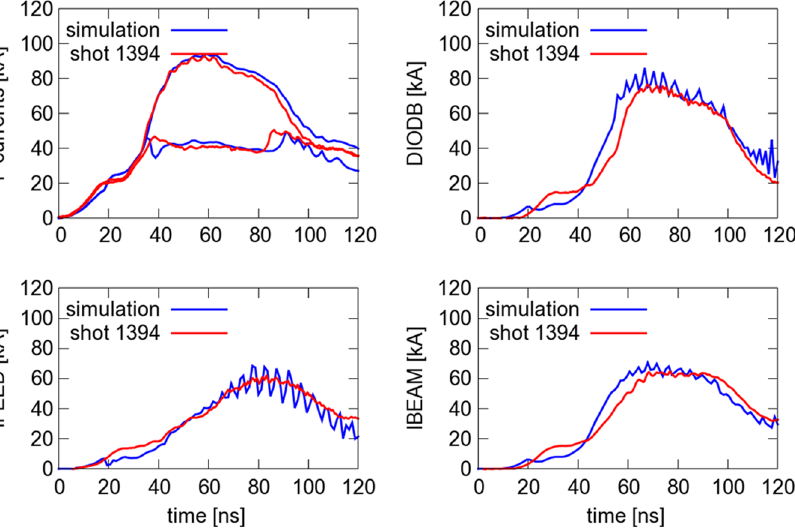
FIG. 6. Currents in the MITL, dustbin, and diode from a simulation of shot 1394 compared to data. The diode has a 8-mm diameter needle and a 8-mm AK gap. The diode impedance in the simulation is